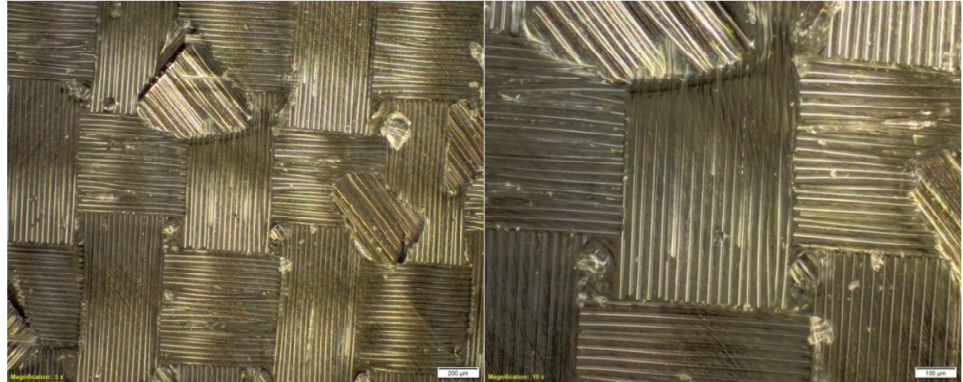
Figure 4. Microstructure of a composite laminate with the reinforcement of the IMS65 CTLX biaxial fabric, reprinted from [31].